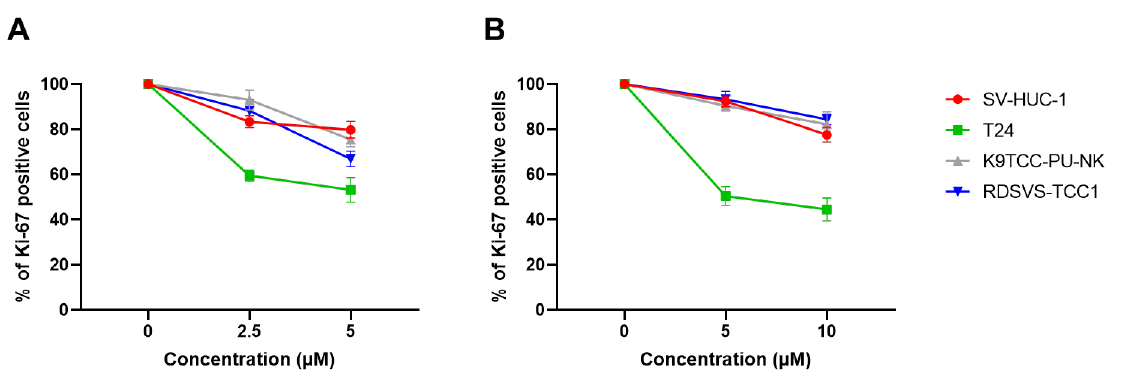
Figure 4. Ki-67 flow cytometry proliferation assay. Percentages of proliferating (Ki-67 positive) cells in reference to control (medium only) after the incubation with increasing concentrations of ( A ) Degrasyn and ( B ) PR-619. Values are presented as means ± standard deviations (SD) of three independent experiments.